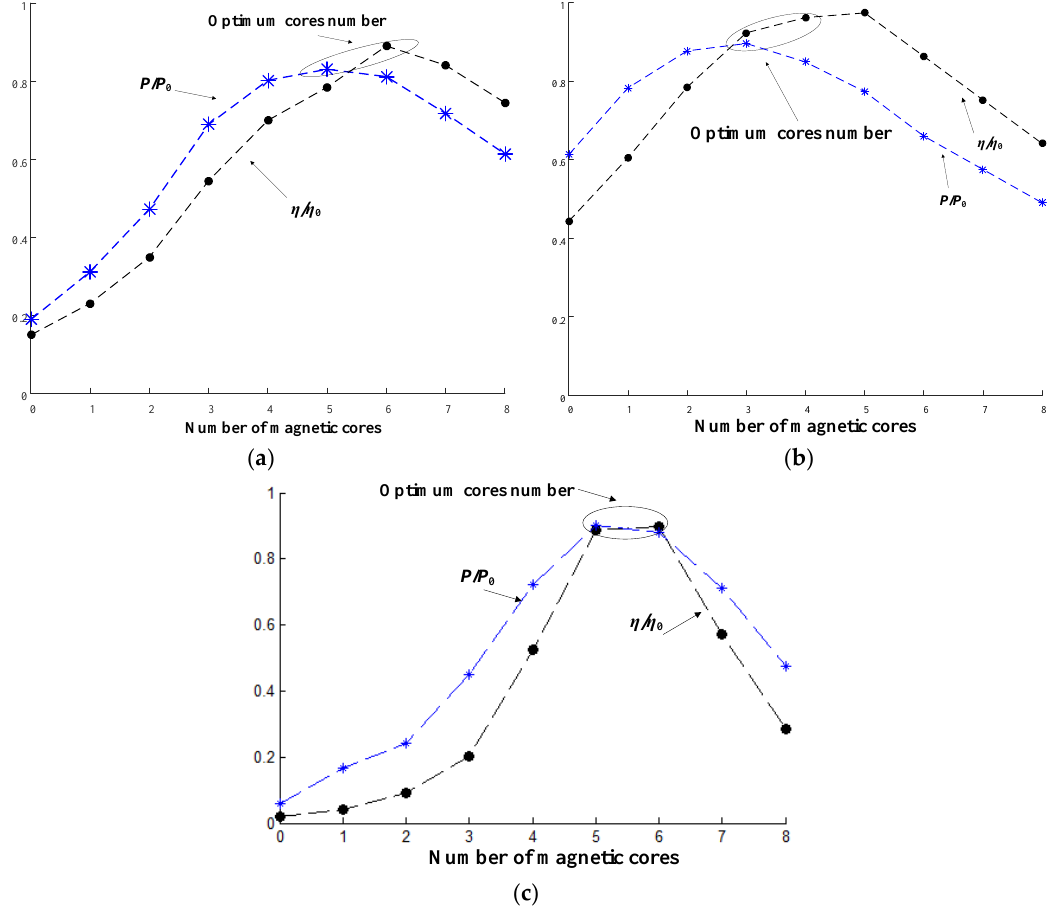
Figure 14. Experimental results: ( a ) The distance between metal plate and receiving coil is 3.5 cm; ( b ) The distance between metal plate and receiving coil is 6 cm; ( c ) The distance between metal plate and receiving coil is 1.5 cm.